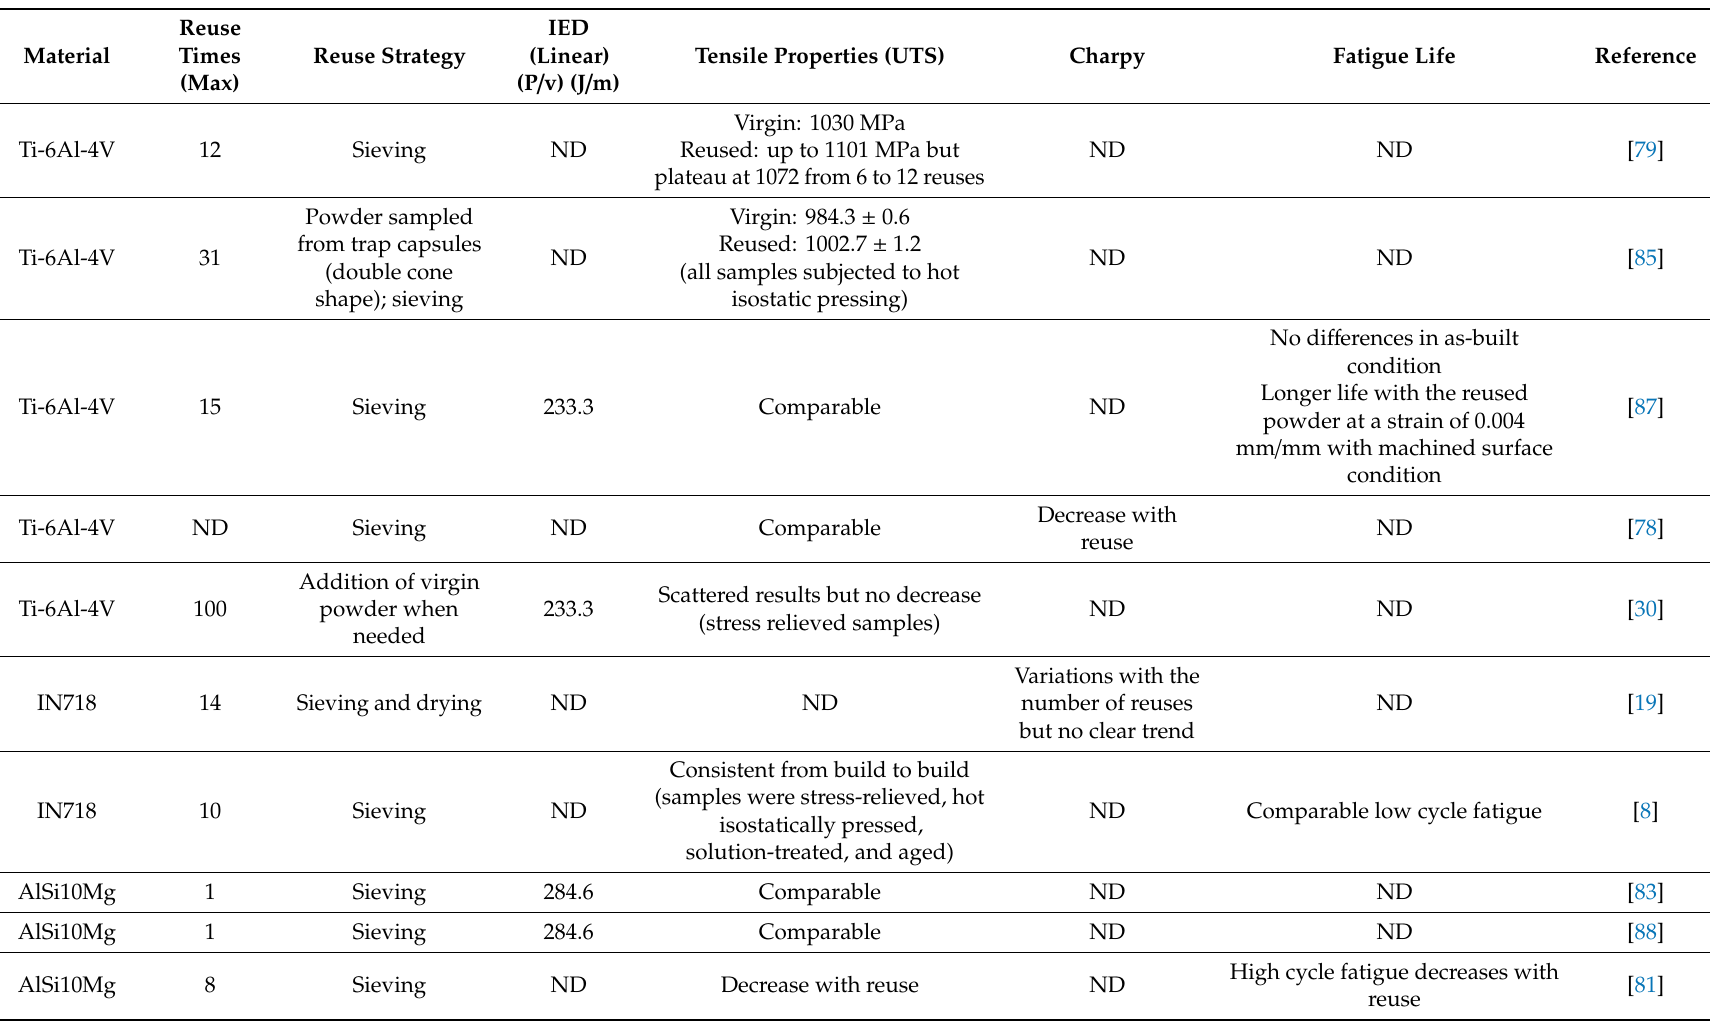
Table 1. Summary of studies on powder recycling (IED—input energy density, UTS—ultimate tensile strength, ND—not